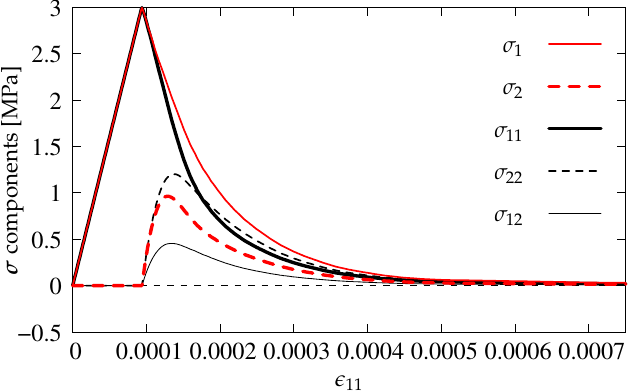
Figure 10. Comparison of stress components for CDP model—plasticity with damage, dilatancy angle ψ = 25 ◦